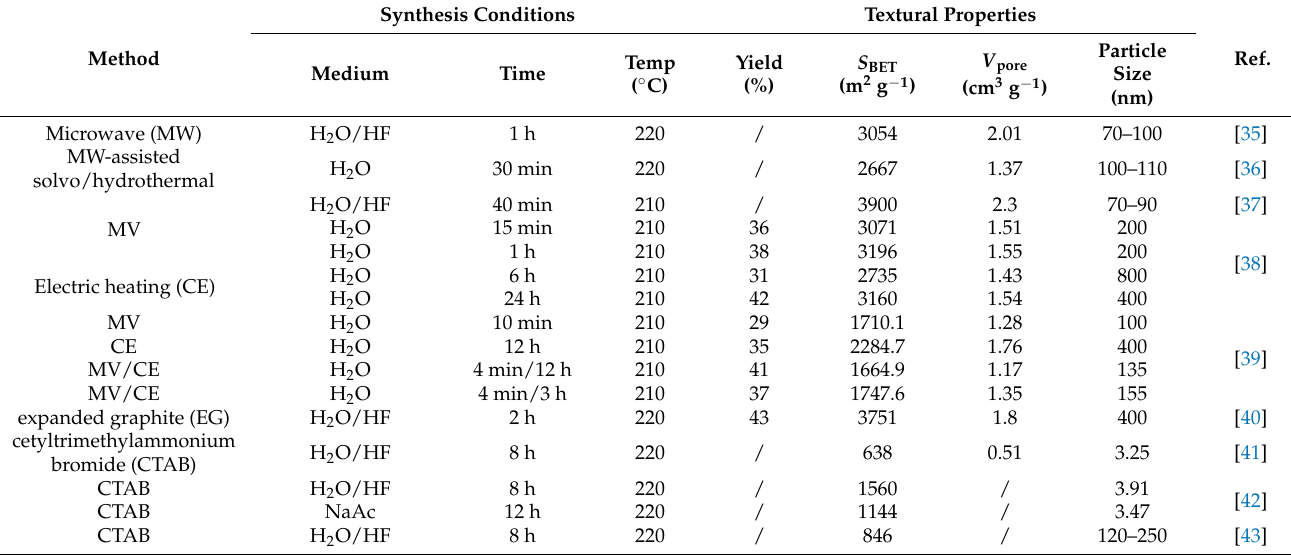
Figure 4. Synthesis process of MIL-101(Cr) ( left ) (the inset shows the adsorption capacity curve of the sample for toluene) and SEM images of MIL-101(Cr) ( right ); ( a ) MIL-101(Cr) as made; ( b ) TMAOH-1@MIL-101(Cr); ( c ) TMAOH-2@MIL-101(Cr); ( d ) TMAOH-3@MIL-101(Cr) [48] . Reprinted from ref. [48]. Copyright © 2022, with permission from Elsevier. Zhao et al. [49] used sodium acetate as an additive to synthesize MIL-101(Cr) and purified it with DMF and ethanol to obtain regular octahedral MIL-101(Cr) crystals with the highest adsorption properties after activation at 140 °C and excellent cyclability. Zhao et al. [27] studied the effect of hydrofluoric acid (HF), nitric acid (HNO 3 ), acidic acid (HOAc), sodium hydroxide (NaOH), and tetramethylammonium hydroxide (TMAOH) on the synthesis of MIL-101(Cr) via hydrothermal synthesis, and the analysis results re- vealed that NaOH as an additive can reduce the particle size of MIL-101(Cr) to nanometer size with an average particle size of 90 nm and a specific surface area of 4065 m 2 g −1 . Jiang et al. [50] used monocarboxylic acid as a modulating agent to synthesize MIL- 101(Cr), the BET surface area of the samples ranging from 2600 to 2900 m 2 g −1 and with the particle size of 19~84 nm. The selectivity of the obtained MIL-101(Cr) towards CO 2 /N 2 was significantly enhanced. The multihole MIL-101(Cr) was synthesized by Hu et al. [28] by using hydrochloric acid as a modulator, which had superior specific surface area and pore volume compared to HF-assisted MIL-101(Cr). The removal of hygromycin from an aque- ous solution was improved by 78% for the newly synthesized sample. Frequently used additives also include acetic acid [31,47,51], nitric acid [26,52], hydrochloric acid [53 – 55],